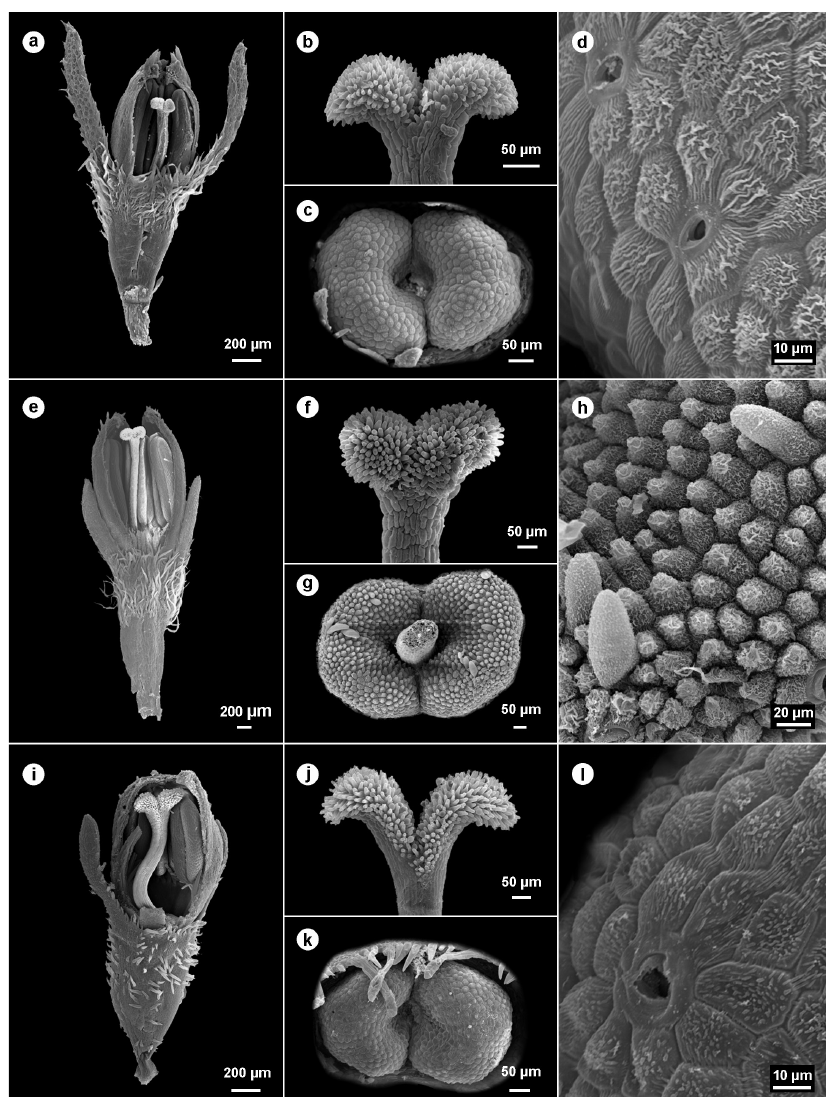
Figure 2 - Flower morphology. a - d . Diacrodon compressus, a . Flower bud. Note the narrowly triangular calyx lobes and the hypanthium pilose in the upper part; b . Shortly bifid stigma, showing short papillae at the inner surface; c . Nectariferous disc; d . Isodiametric and uniform disc cells; e - h . Borreria spinosa, e . Flower bud. Note the narrowly triangular calyx lobes and the hypanthium puberulous in the upper part; f . Bilobed stigma, showing fully surface covered with papillae; g . Nectariferous disc; h . Conical and not uniform disc cells. Note some of them with a greater length; i - l . B. verticillata , i . Flower bud. Note the spatulate calyx lobes and the hypanthium pilose in the upper part; j . Shortly bifid stigma, showing papillae at the inner surface; k . Nectariferous disc; l . Isodiametric and uniform disc